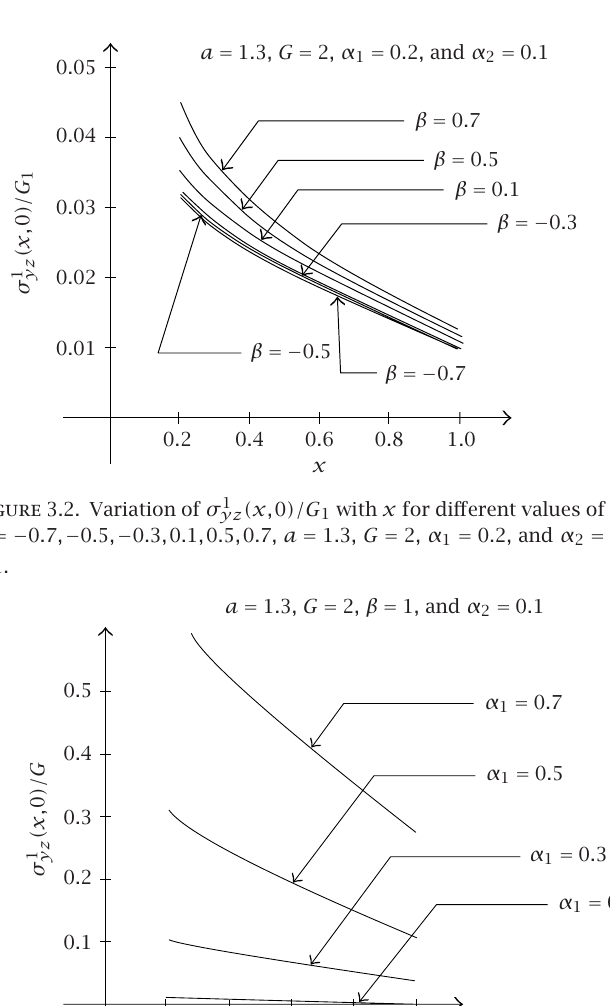
x for different values of 1 with = 0 . 1, and β = 2